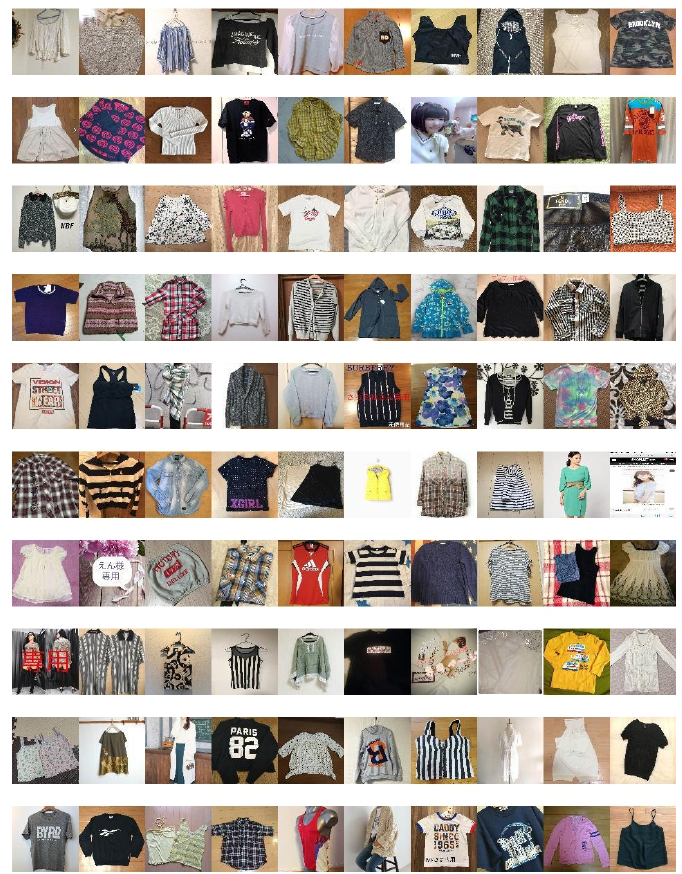
Figure 2. Sample images from the consumer-to-consumer (C2C) market dataset collected by